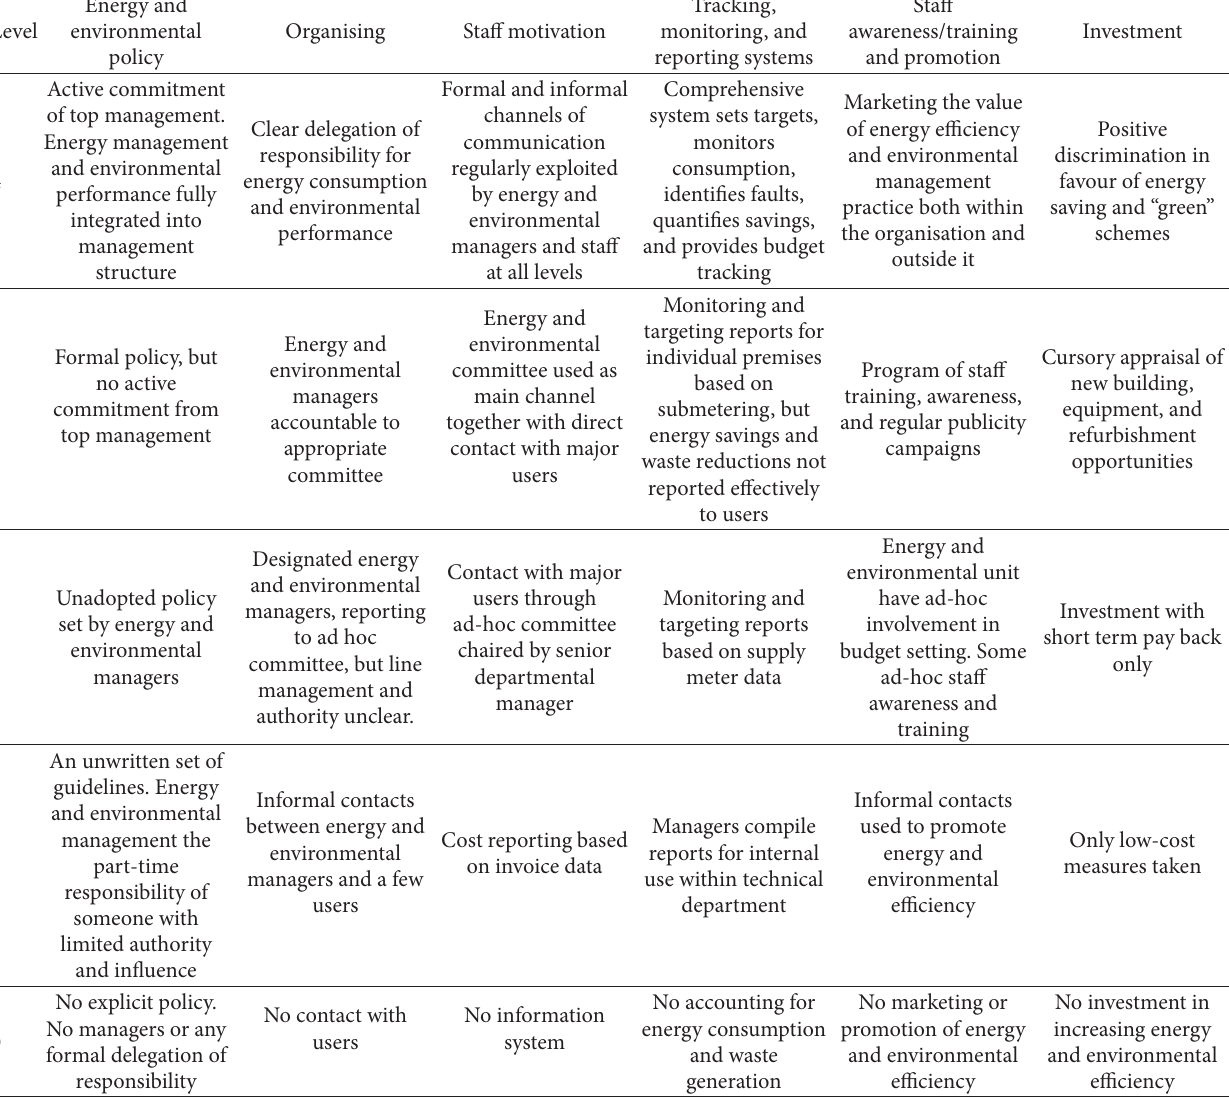
Table 2: Energy and environmental management